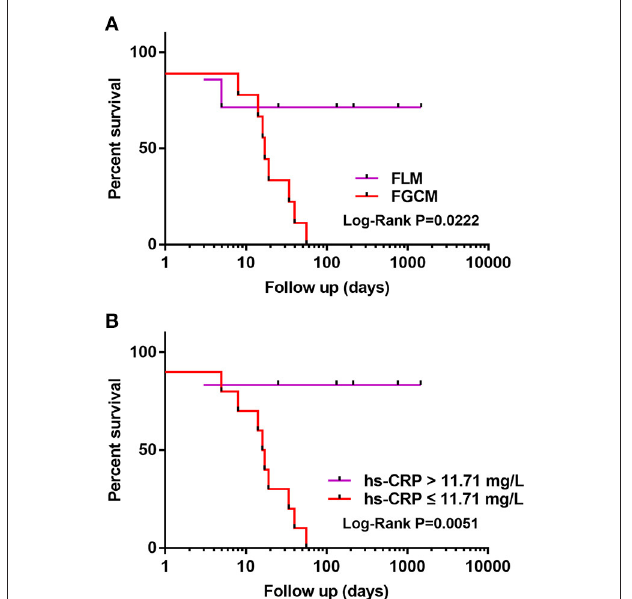
FIGURE 3 | (A,B) Kaplan-Meier curve illustrating transplant-free survival in FGCM and FLM patients. Patients with FGCM and lower hs-CRP levels (hs-CRP ≤ 11.71 mg/L) showed a significantly worse prognosis during follow-up of 4 years (log-rank test).